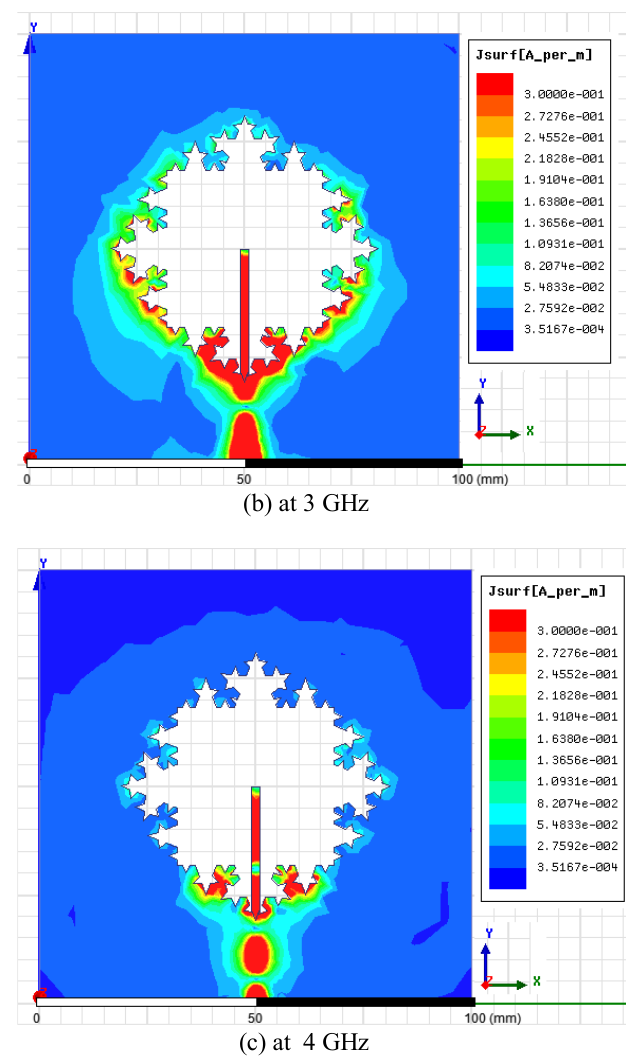
Figure 9. The Electric current distribution of Antenna 3 at various frequencies. Table 2: Comparison of the proposed antenna with reference